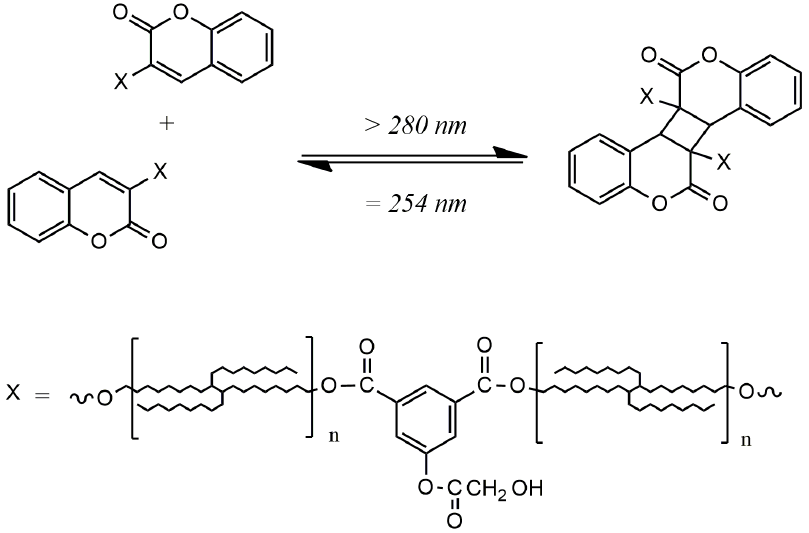
Figure 2. Photochemical [2 + 2] cycloaddition of coumarin-containing fatty acid dimer diol.